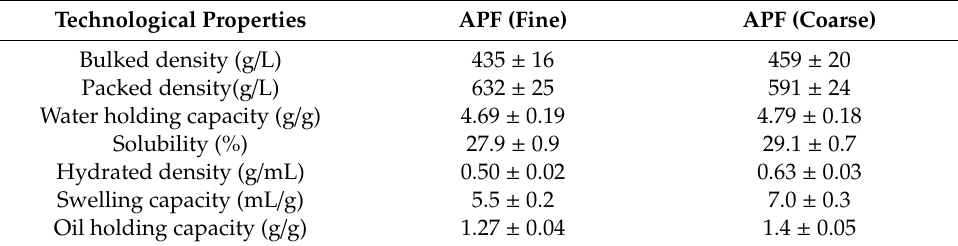
Table 1. Technological properties of coarse and fine apple pomace flour